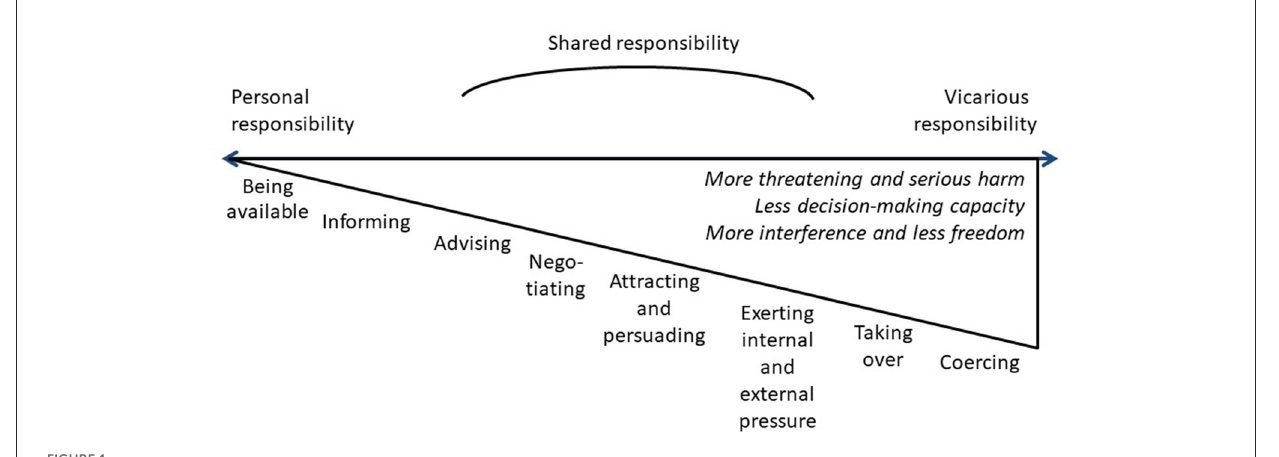
FIGURE1 Assertive or gradual